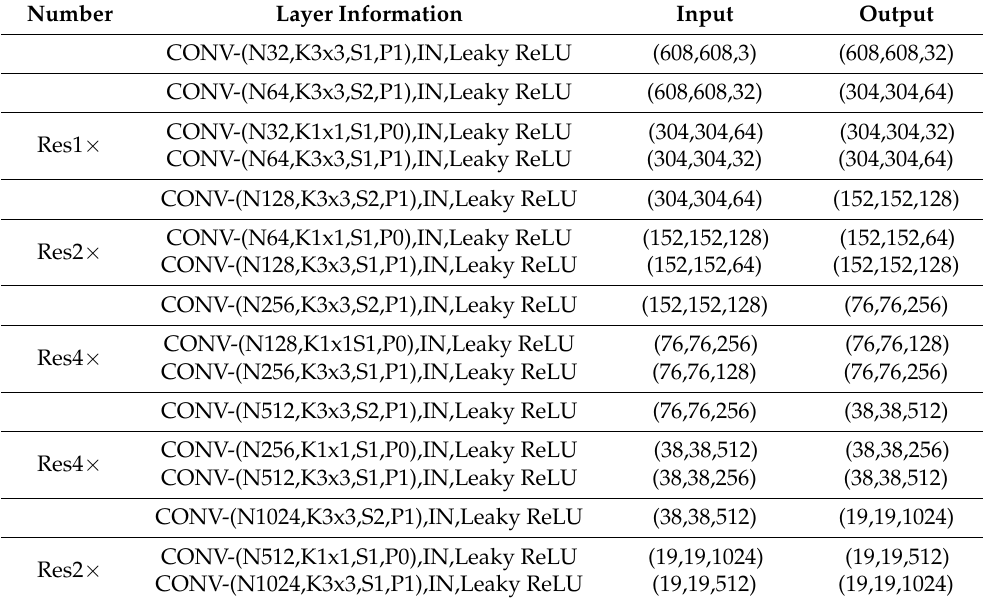
Table 1. Applied kernels of backbone in